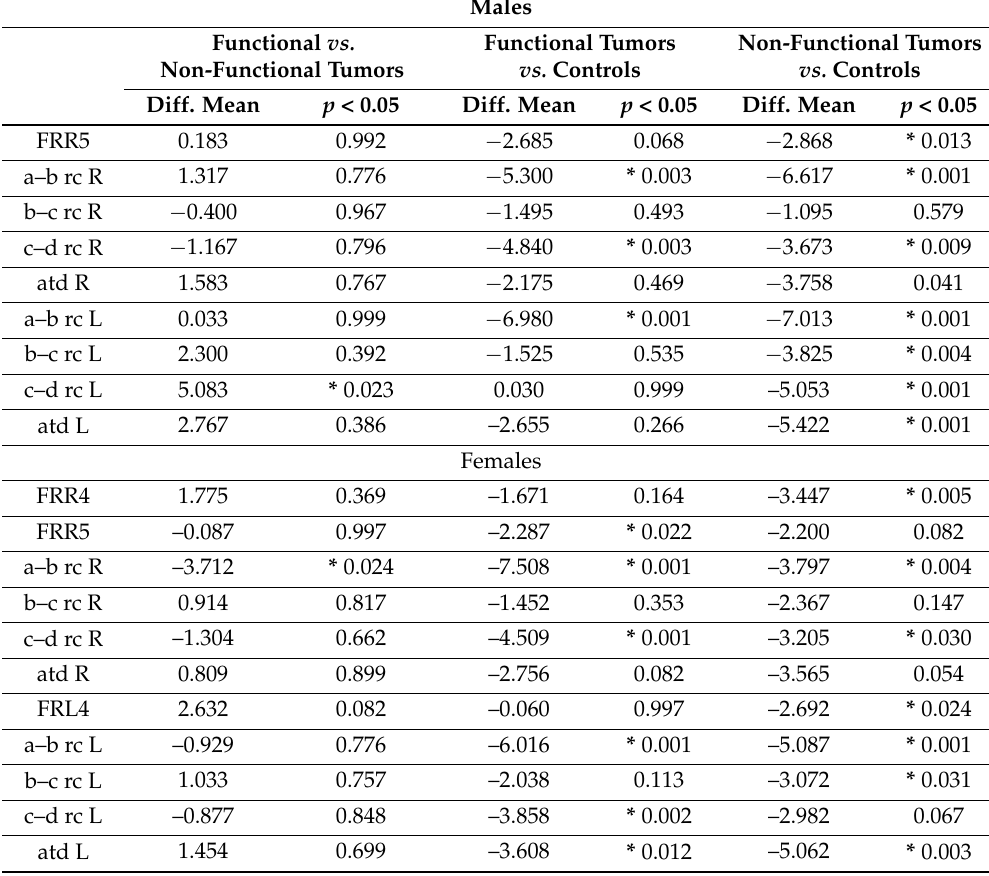
Table 2. ANOVA Tukey post hoc test analysis of quantitative dermatoglyphic traits in males and females comparing groups with functional tumors, non-functional tumors, and controls (statistically significant variables are